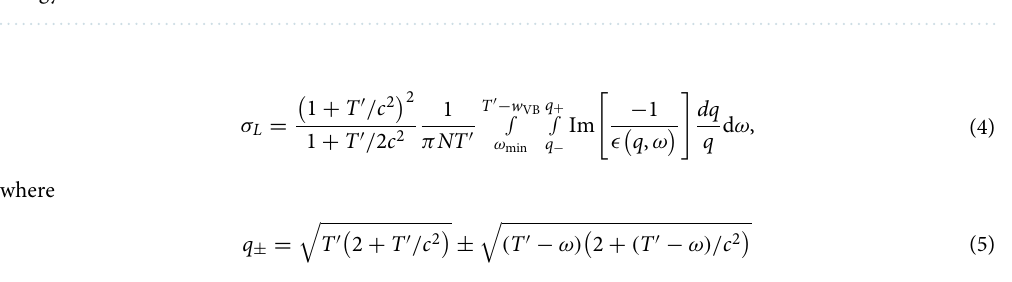
Figure 1. Energy loss function for CaF 2 where the exciton states can be observed just below the bandgap